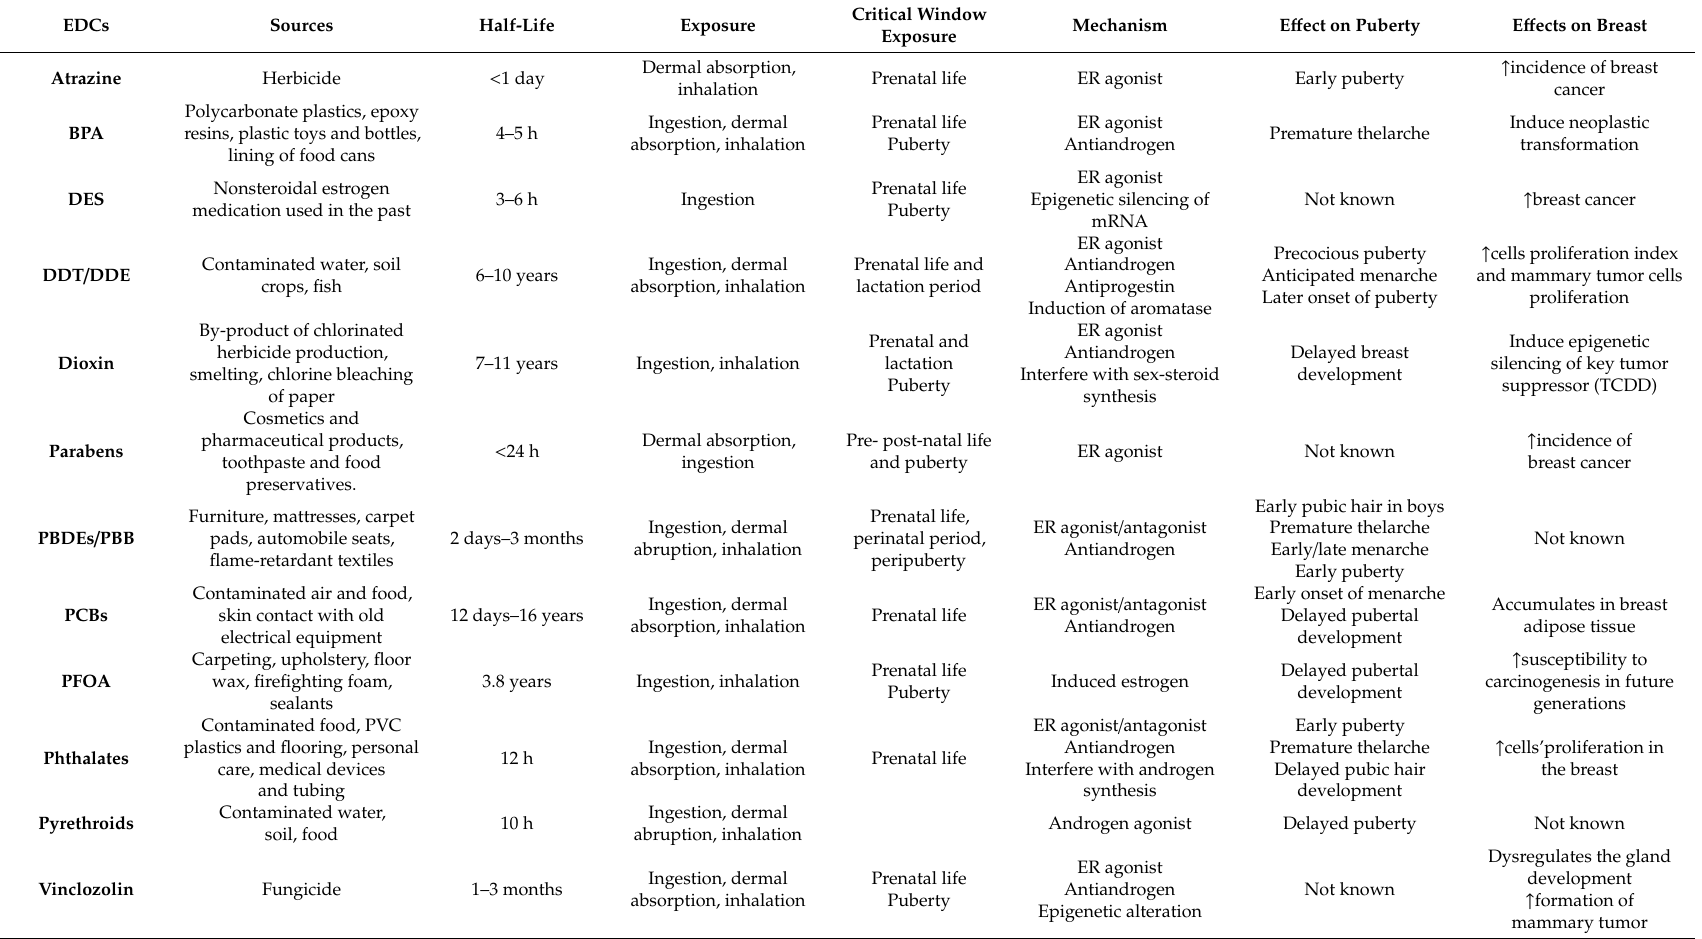
Table 1. Description of several EDCs and their e ff ects of puberty and breast cancer